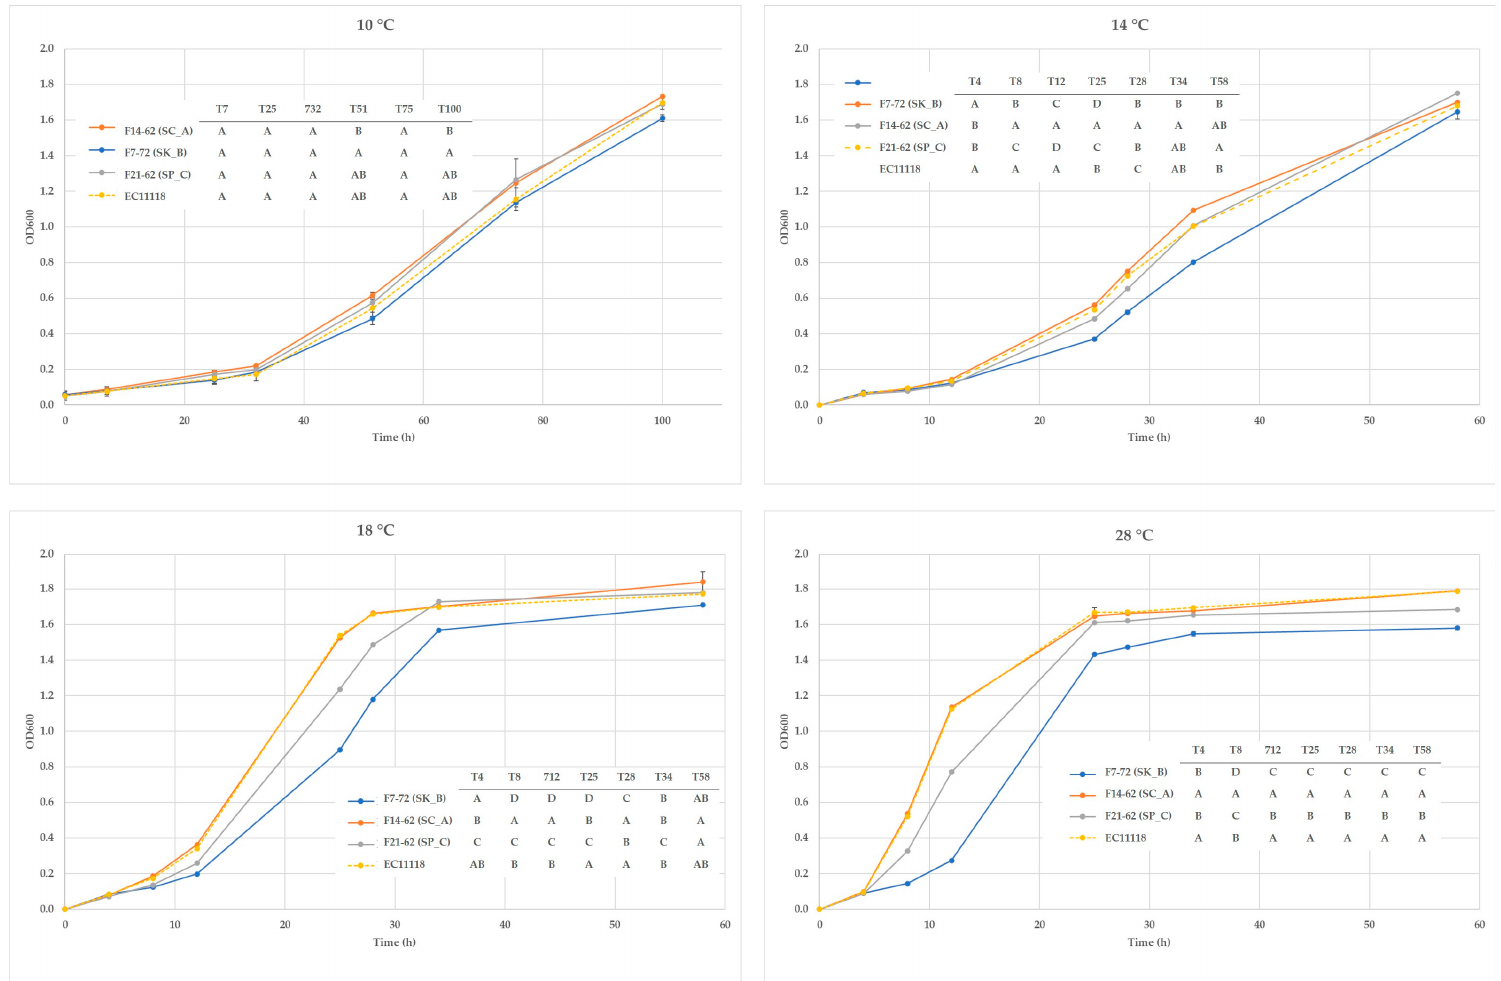
Figure 1. Growth kinetics at different temperatures of the three strains in YPD broth at pH 3.2. Different letters at each sampling point indicate significant differences (ANOVA: Tukey t ‐ test. p < 0.05—XLStat).